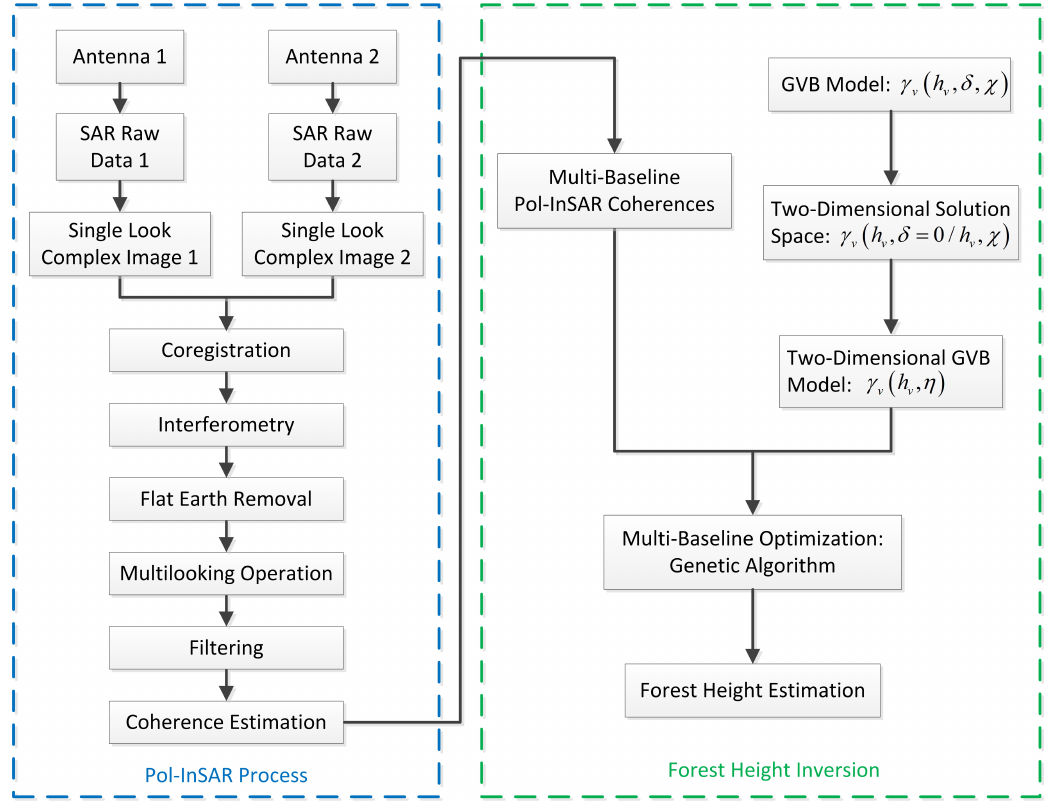
Figure 6. Flowchart of the proposed two-dimensional GVB modeling and multi-baseline